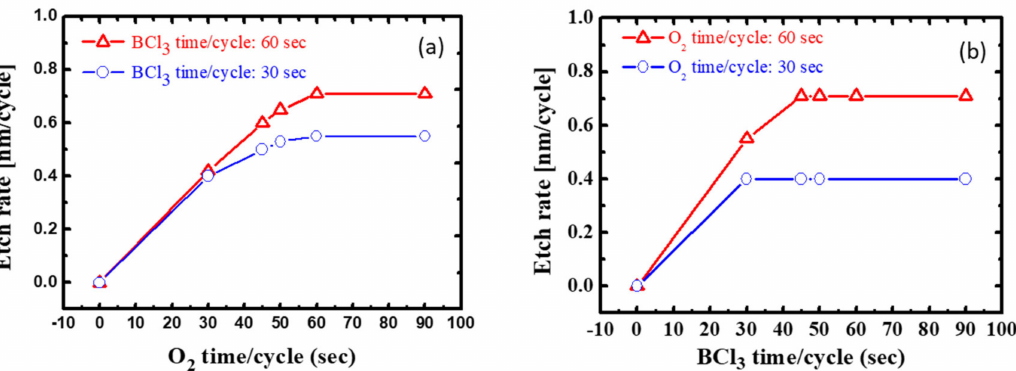
Figure 3. Etch rate per cycle of the atomic layer etching (ALE) for ( a ) varying O 2 and fixed BCl 3 plasma times per cycle and ( b ) varying BCl 3 and fixed O 2 plasma